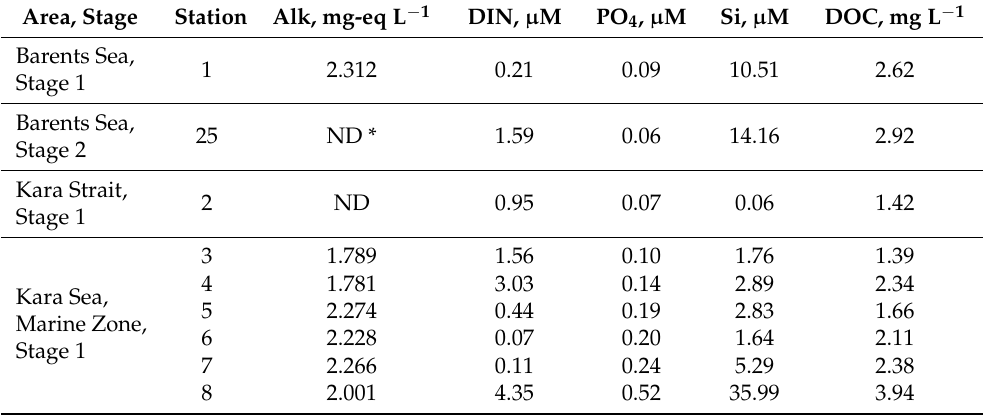
Table 2. Chemical properties of the sampling locations in the Barents and Kara Seas from 29 June to 15 July 2018: alkalinity (Alk), dissolved inorganic nitrogen concentration (DIN = NO 2 + NO 3 ), phosphate concentration PO 4 , silicate concentration (Si), and concentration of dissolved organic carbon